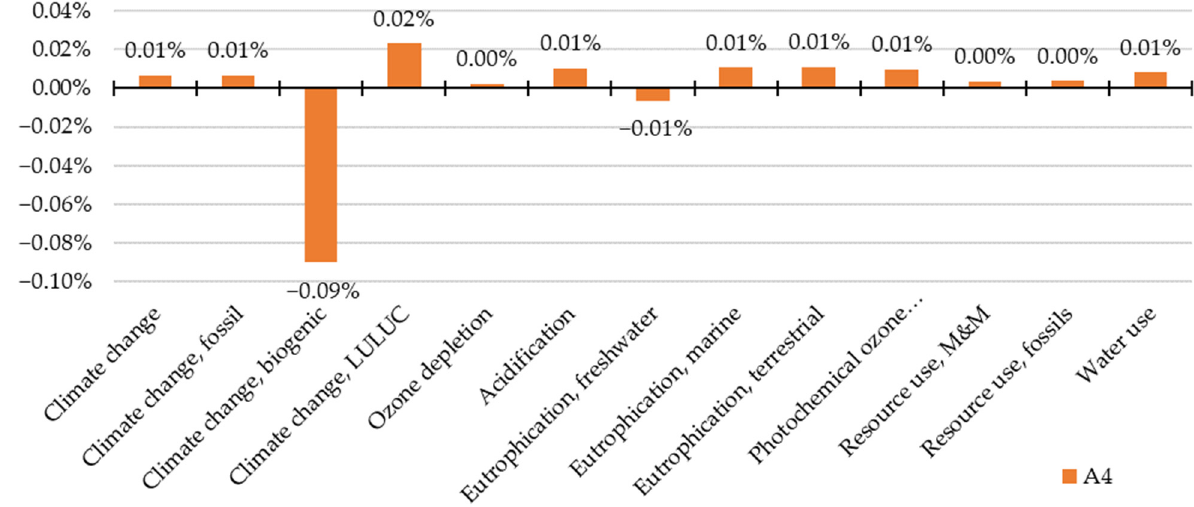
Figure 4. Environmental impact shift of the A4 stage considering photovoltaic energy storage.